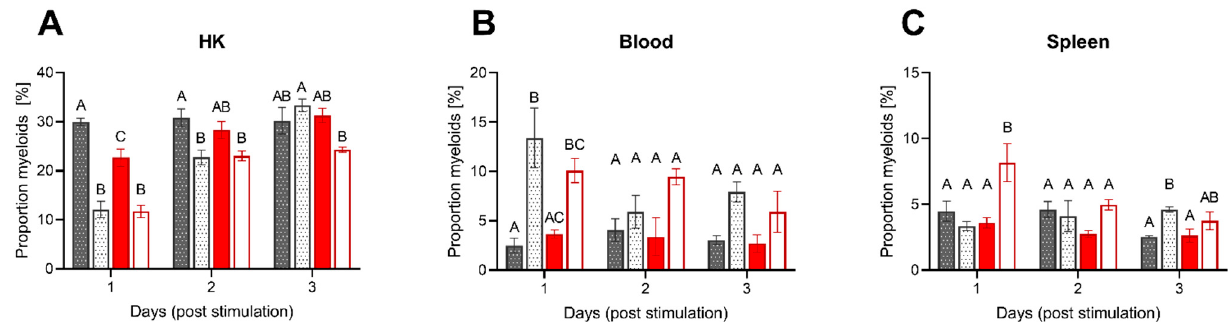
Figure 7. Proportion of myeloid cells within HK, peripheral blood and spleen of pikeperch upon intraperitoneal stimulation. Proportion (%) of myeloid cells in head kidney (HK; A ), peripheral blood ( B ) and spleen ( C ) samples of pikeperch after one, two and three days post intraperitoneal stimulation with inactivated Aeromonas hydrophila cells. The graph shows differences between normoxic control groups, either unstimulated (dark grey/patterned) or stimulated (bright grey/patterned), and low DO groups, either unstimulated (dark red) or stimulated (bright red). Columns represent mean of four individual samples (+SEM). Statistical significance per each day was determined using the one-way ANOVA followed by Tukey ´ s multiple comparison test ( p = 0.05); different letters (A–C) represent significant changes between different groups.